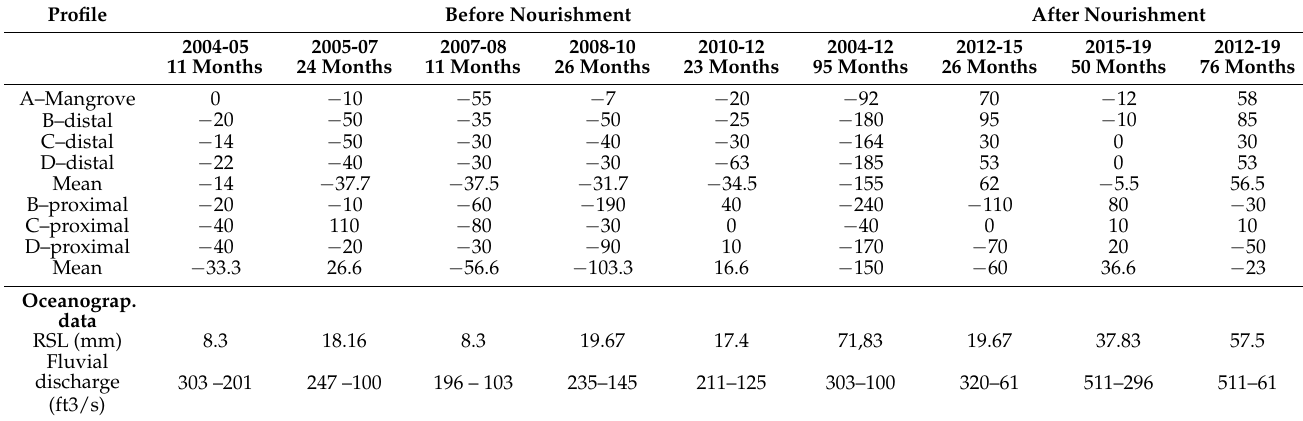
Table 1. Retreat and advance of the distal and proximal limits of the shoreline (m) before and after the nourishment project with a margin of error of ± 2.5 m. Data based on Quickbird images, using reference the transects A, B, C, and D (see location in Figure 4). Also included in this table are: the relative sea-level rises, data based on the relative sea-level trend of 9.08 ± 0.42 mm/year (1947–2018) recorded in Grand Isle, 26 km northeast of the study area; and the average highest and lowest monthly fluvial